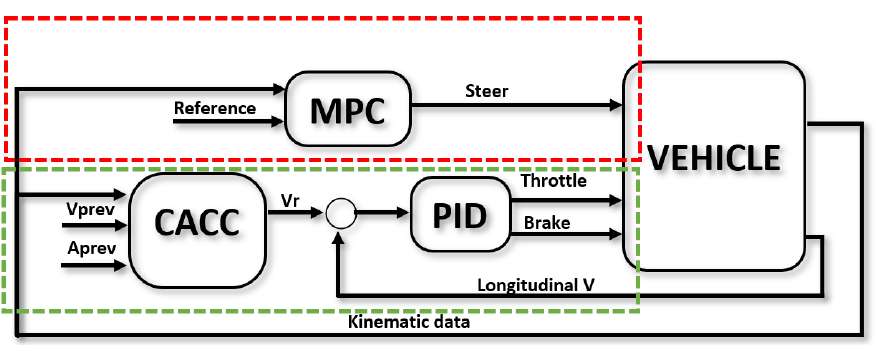
Figure 5. Control for platooning. Blocks inside the red area are related to the lateral controller, while the ones inside the green area are related to longitudinal